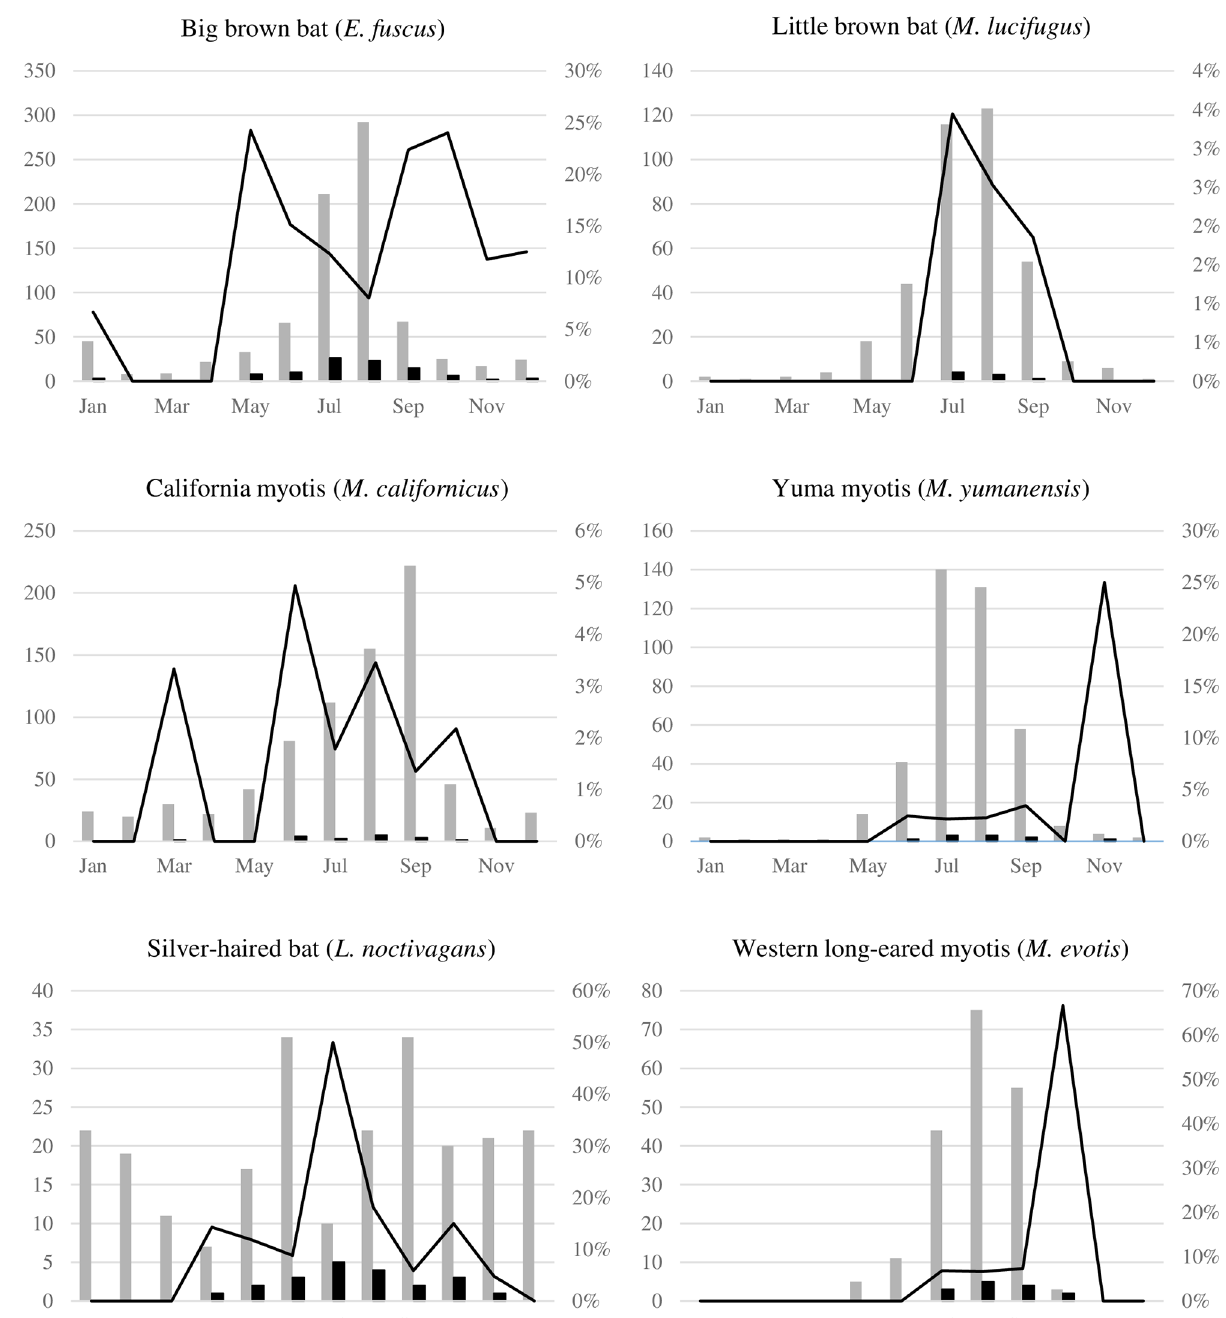
Fig 2. Numbers of bats tested (grey bars), number of RABV positive bats (black bars), and RABV positivity (black line) by month for bat species with (cid:21) 100 submissions and definitive test result, Washington